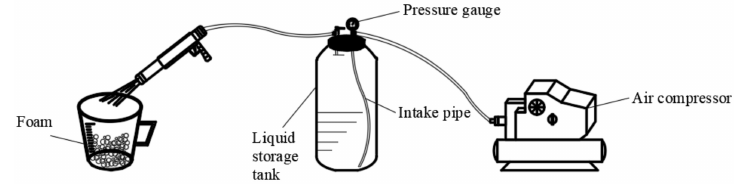
Figure 11. Schematic diagram of the foam generator.